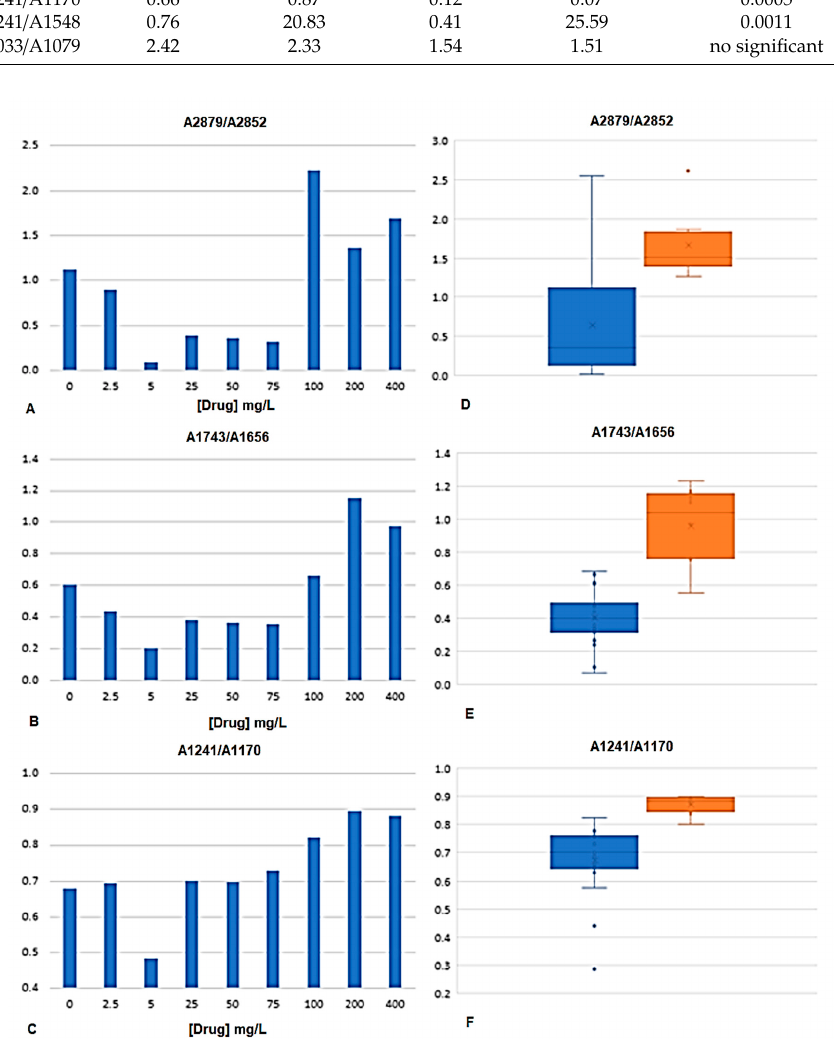
Figure 5. Peak ratios of bacteria spectra at A2879/A2852, A1743/A1656, and A1241/A1170. (A-C) Average values obtained along with diverse drugs concentration. (D-F) Box-plot graphs of peak ratios from drug concentrations lower to the MIC (blue boxes) and equal or higher to the MIC (orange boxes).